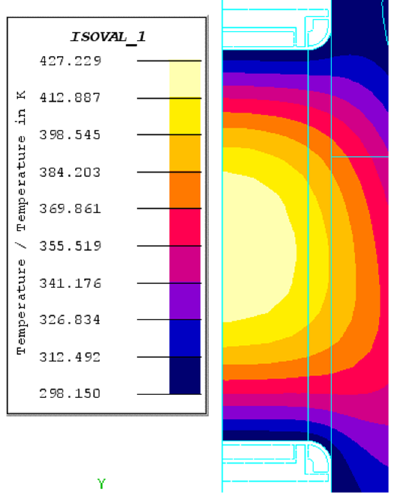
Figure 6. Temperature field of crankshaft N0 after liquid cooling.